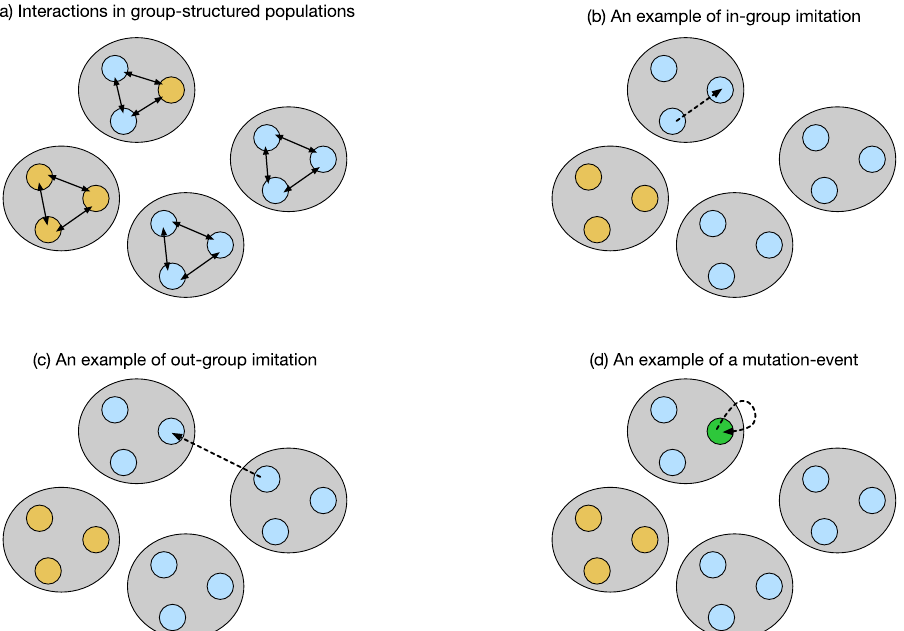
Figure 1. A schematic representation of the model setting. ( a ) We consider pairwise interactions in group- structured populations. The population is composed of M groups (depicted by grey sets). Each group contains N players (depicted by colored circles). In this example, M = 4 and N = 3 , such that the total population size is NM = 12 . The colors of the small circles indicate the players’ strategies. The black arrows between these circles indicate that each player interacts in a repeated prisoner’s dilemma with all other group members. Over time, players may change their strategies for the repeated prisoner’s dilemma in three different ways. ( b ) First,